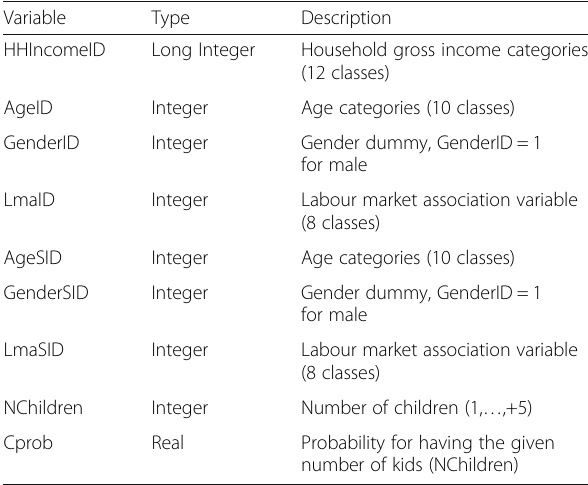
Table 10 Marginal probabilities of having a specific number of kids in certain types of household compositions